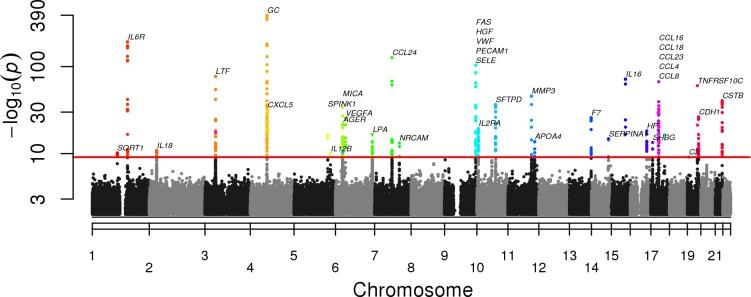
Genome wide associations between single nucleotide polymorphisms (SNPs) and blood biomarkers.Combined Manhattan plots show pQTL SNPs by chromosomal location for 38 biomarkers with at least one SNP significant at genome wide significance after adjustment for multiple testing (red line). The -10logP values are shown using results from a meta-analysis of both SPIROMICS and COPDGene SNPs. The abbreviation for the biomarker associated with the pQTL SNP can be found in S1 Table.